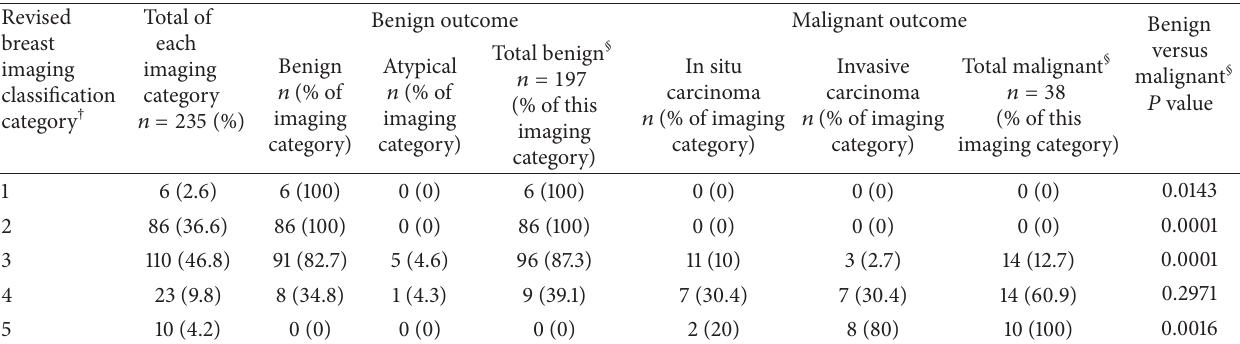
Table 3: Distribution of revised breast imaging classification as a result of assessment, with final outcome ∗